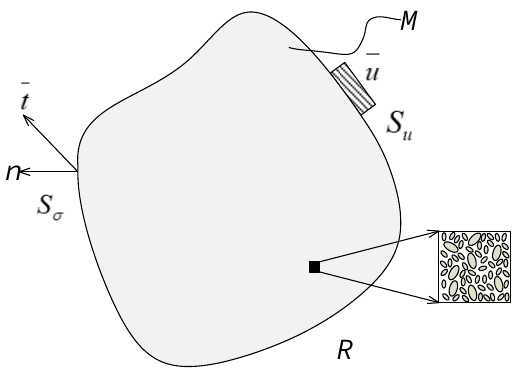
is the traction. i